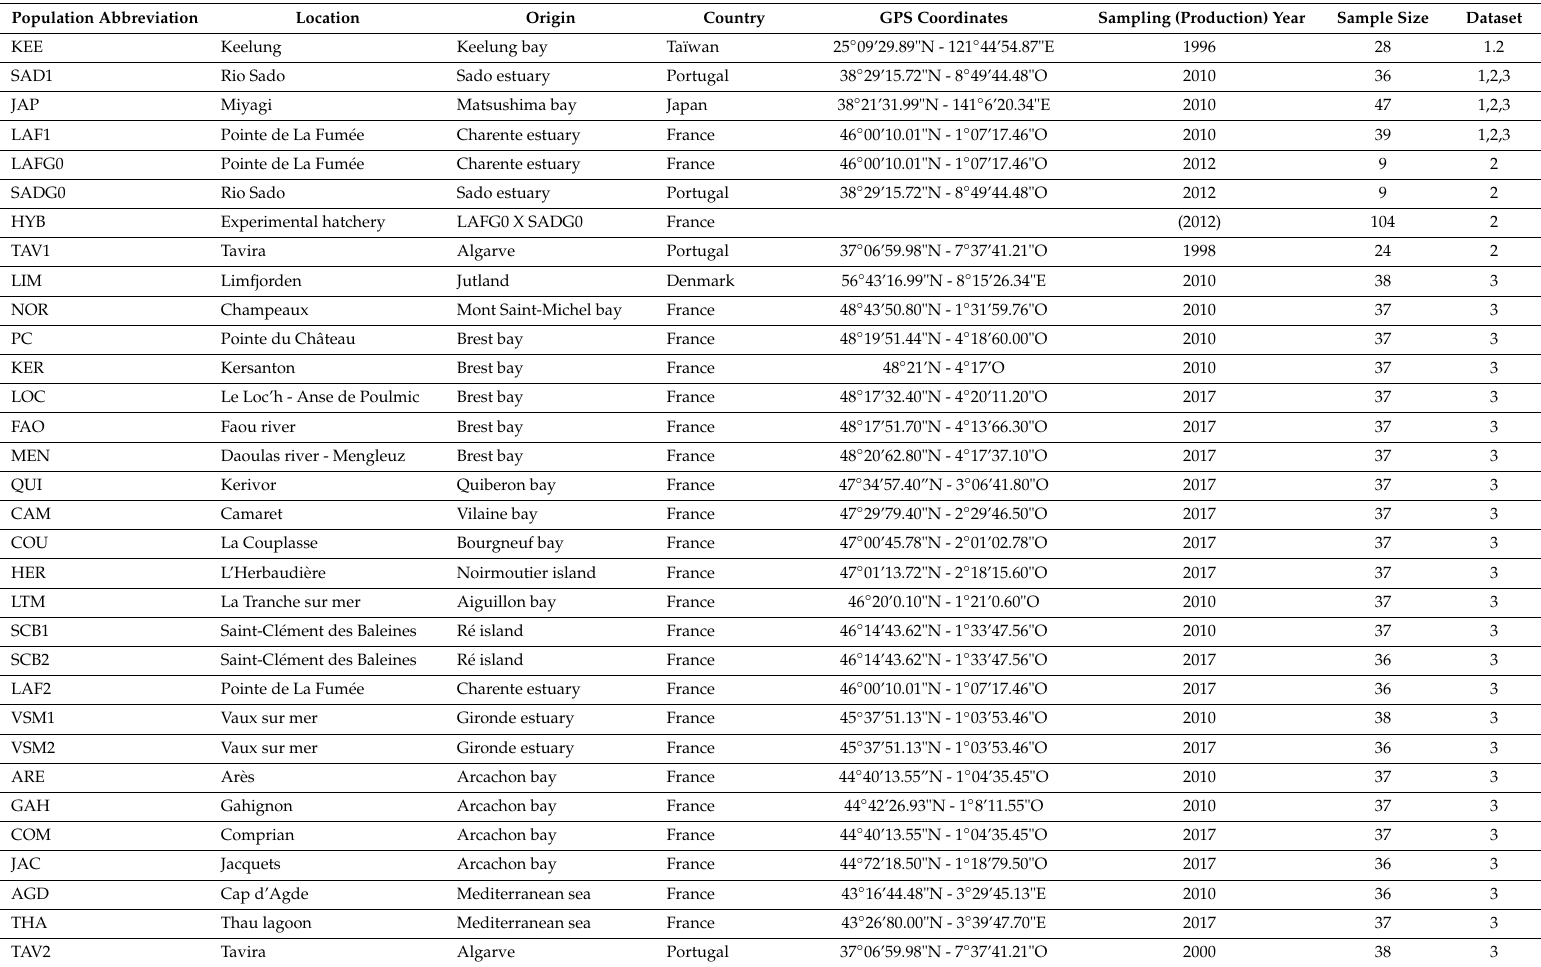
Table 1. Characteristics of the locations